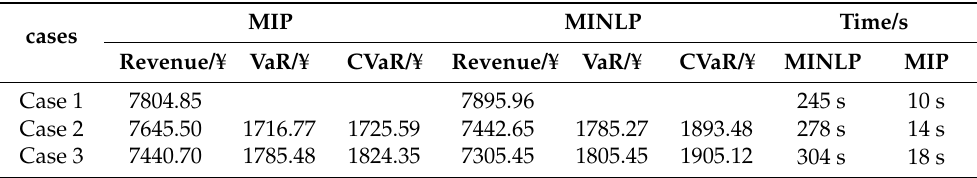
Table 7. Scheduling results of the VPP before/after linearizing model in typical summer